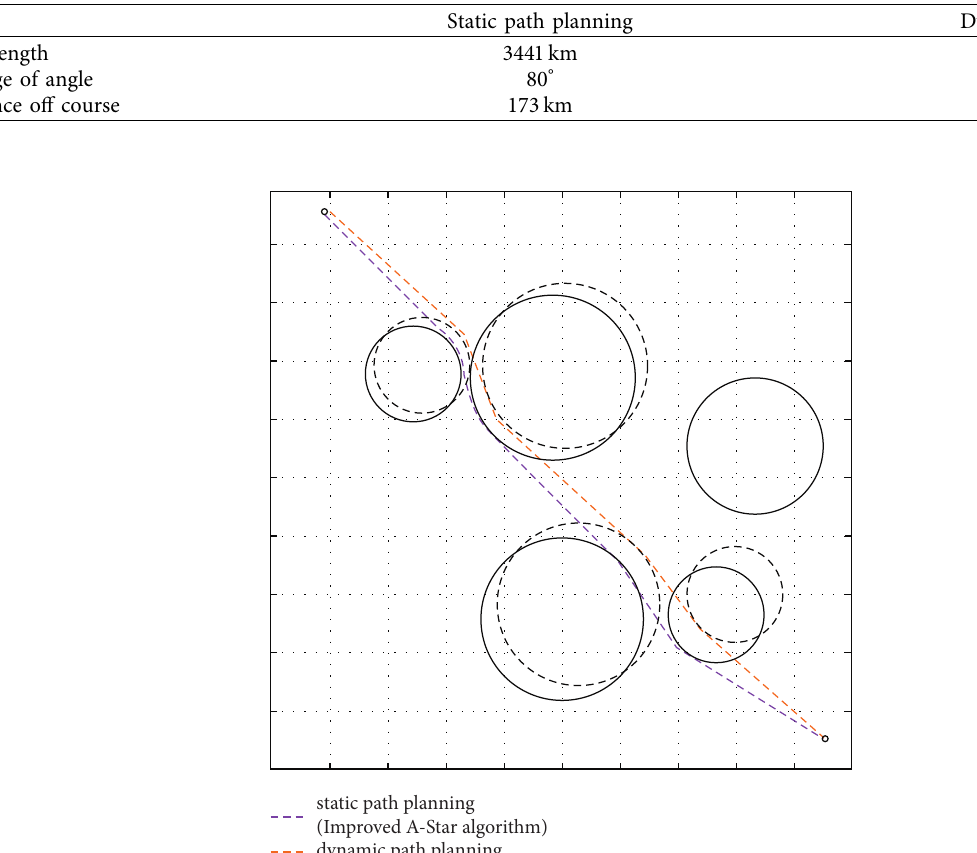
Figure 22: Comparison of the improved A-star algorithm and traditional A-star algorithm from Algiers to Rome. Table 10: The results of dynamic path planning from Madrid to Cairo.